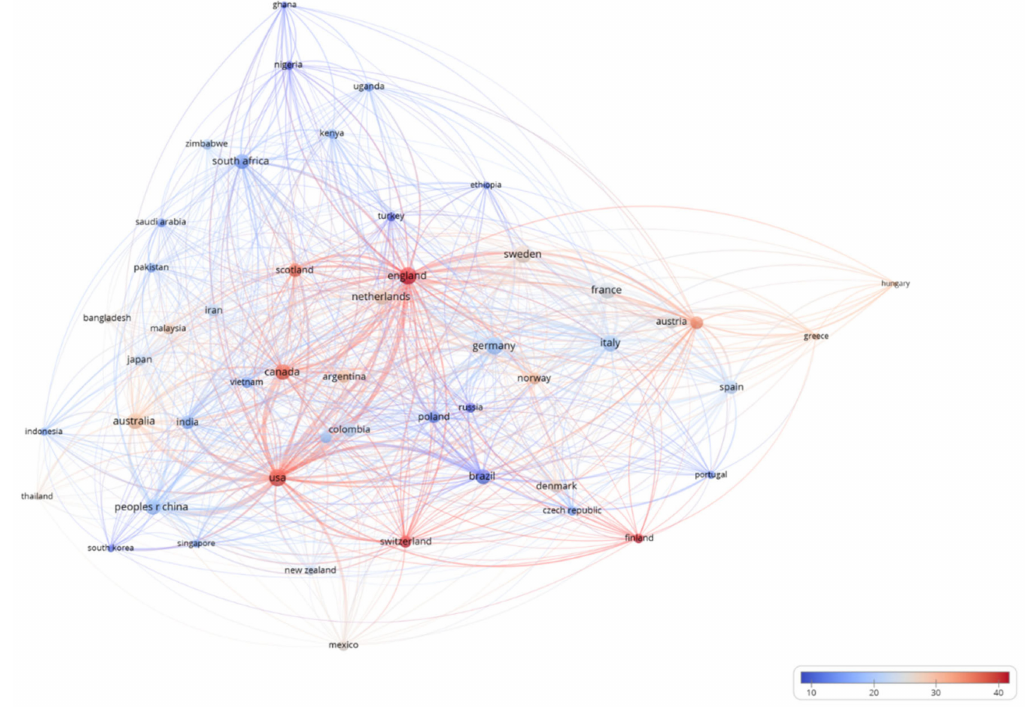
Figure 3. Co-occurrences of